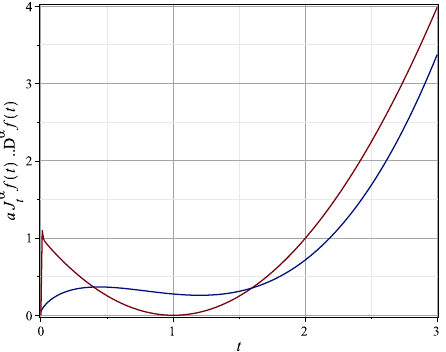
Figure 1. Time-domain response of (8) (blue line) and (10) (red